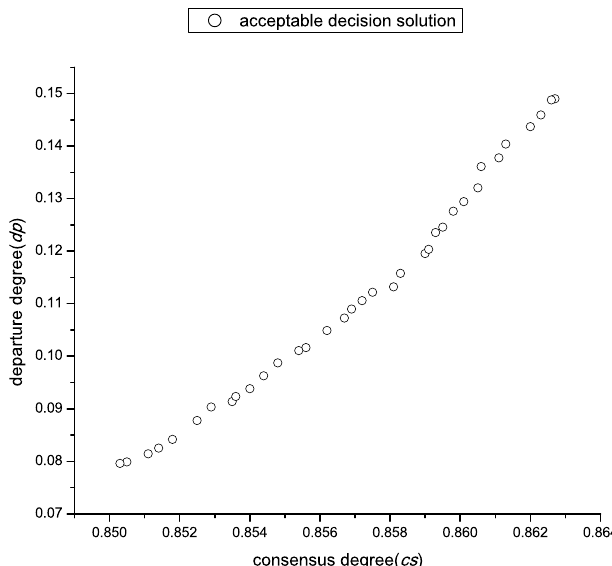
Figure 4: Obtained acceptable decision solutions of the multi-objective optimization problem of the decision preferences given by DMs after the first round of interactive